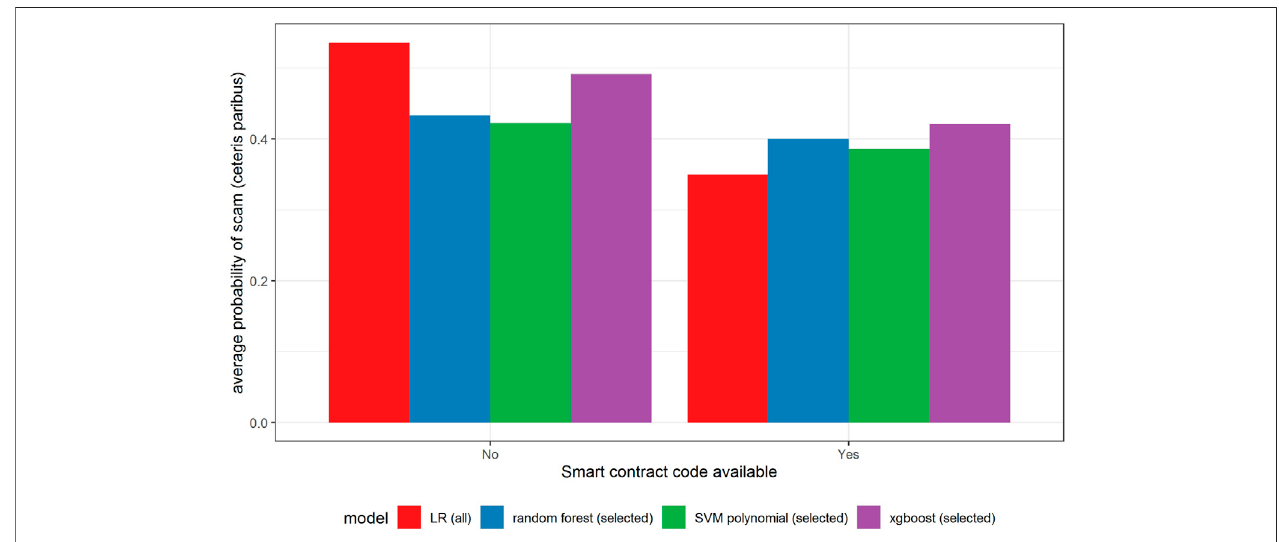
FIGURE 10 | Partial dependence plot for variable indicating the availability of smart contract code.